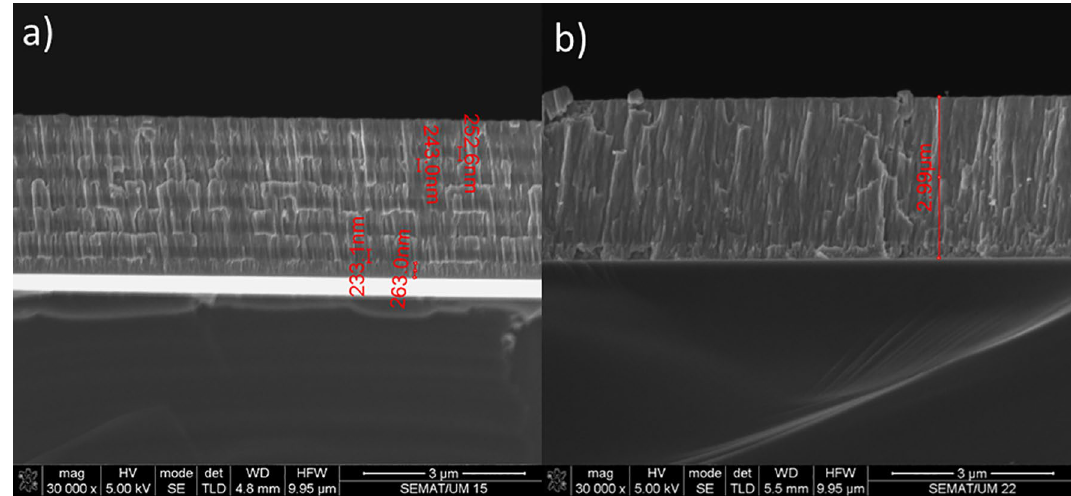
Figure 5. Cross-section FESEM images for samples ( a ) PN10 and ( b )